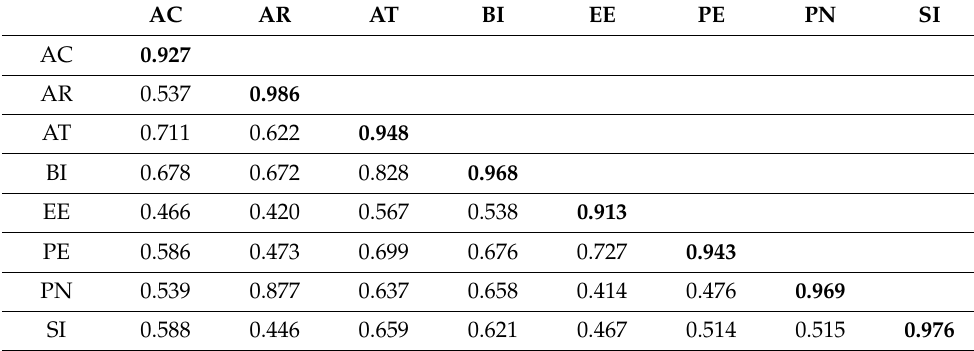
Table 4. Each construct’s square root of the AVE (in bold) and its association with other